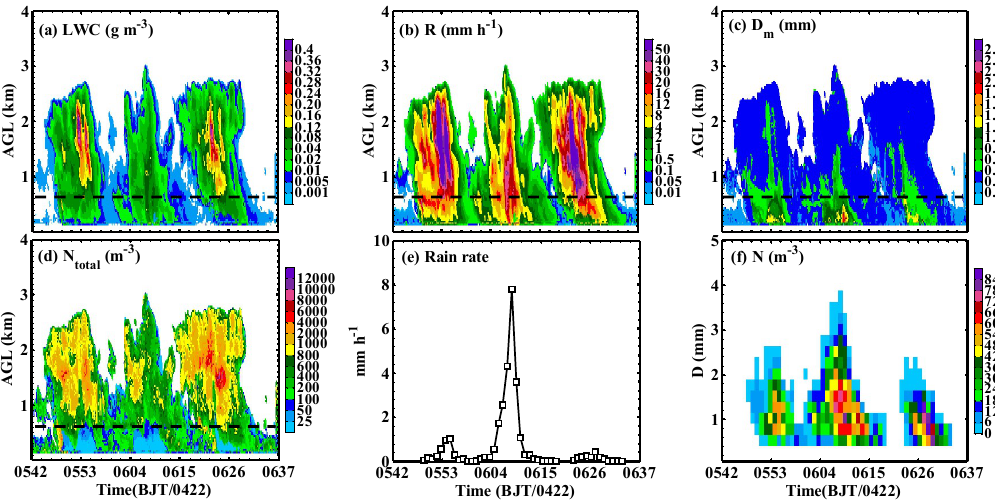
skewness, and spectral kurtosis. spectral